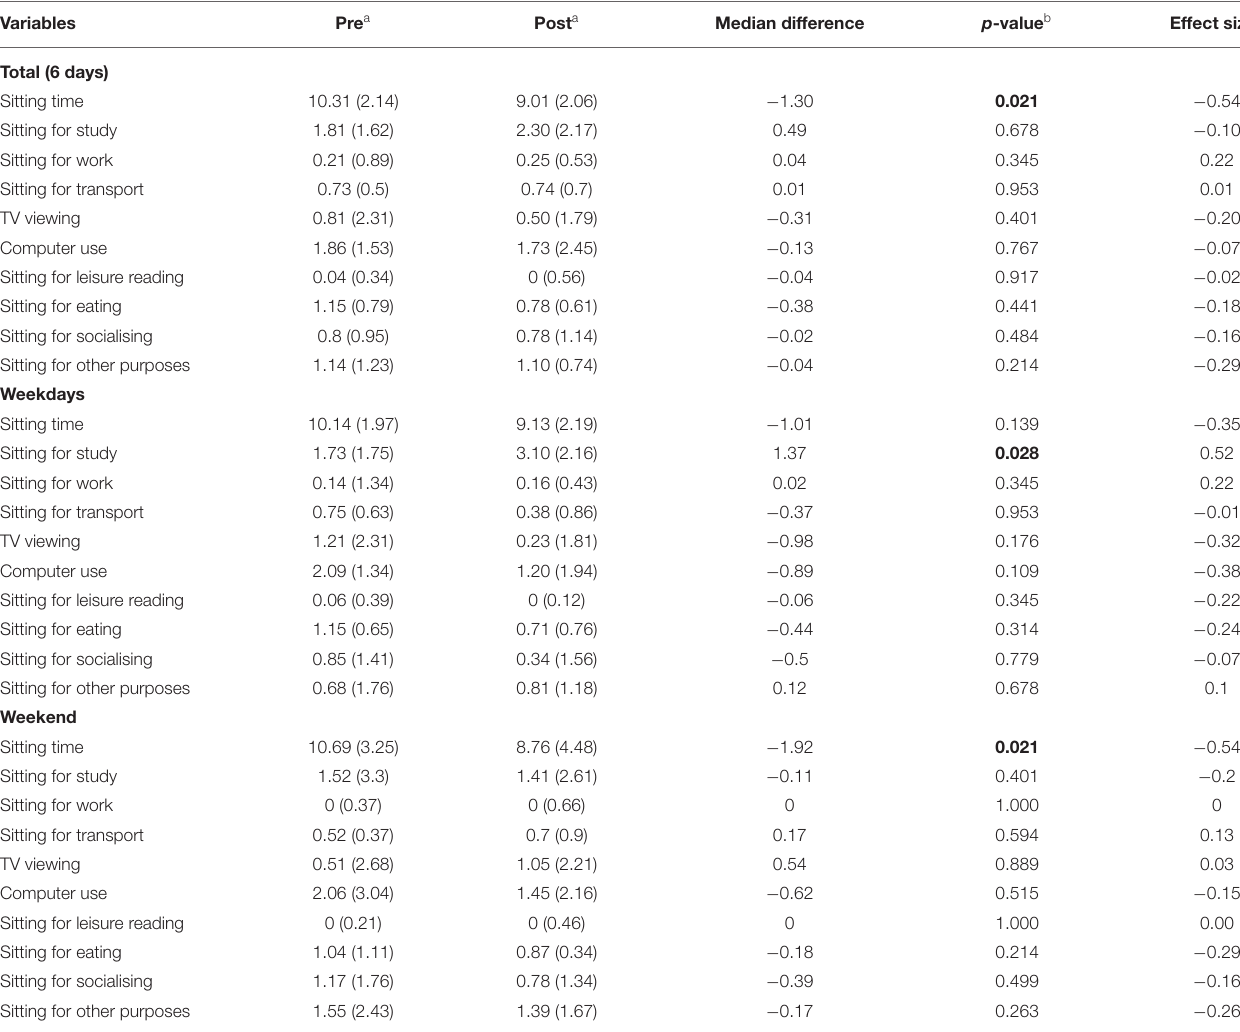
TABLE 5 | Descriptive statistics and pre-post comparison (related samples Wilcoxon Signed Rank Test) for each of the Nightly-Week-U dimensions ( n = 9). Variables Pre a Post a Median difference p -value